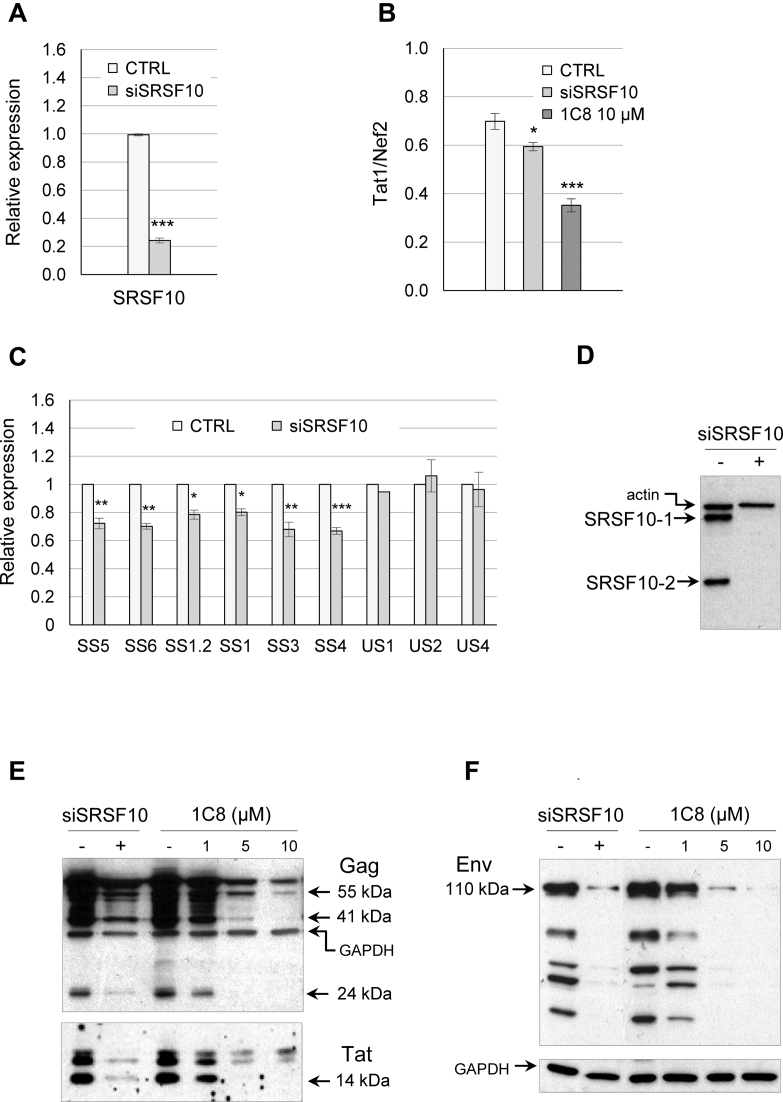
Impact of the depletion of SRSF10 on HIV-1 expression. (A) Quantitative RT-PCR was used to assess the level of depletion of endogenous SRSF10 in the HeLa-HIV cell line. (B) The AS2 set of primers was used to monitor the production of Tat1 and Nef2. Endpoint RT-PCR assay from HeLa-HIV cells depleted of SRSF10 by siRNA or treated with 10 μM of 1C8. The histograms show the impact of the depletion and of 1C8 on the ratio of Tat1 and Nef2 products. (C) Using primer pairs described in Figure 1D, quantitative RT-PCR assays were performed on RNA from HeLa-HIV cells treated with siSRSF10. The intensity of products in histograms was normalized relative to the amount produced in the controls (which corresponds to an arbitrary unit value of 1). Asterisks indicate significant P values when comparing the difference between the means of values from samples treated with siSRSF10 versus values from mock-treated samples; *P < 0.05, **P < 0.01 and ***P < 0.001. (D) Knockdown of SRSF10 with siSRSF10 as verified by immunoblotting. (E) Western analysis of HIV-1 Gag, Tat and Env proteins. Equivalent loading was confirmed by reprobing blots with anti-GAPDH antibody.